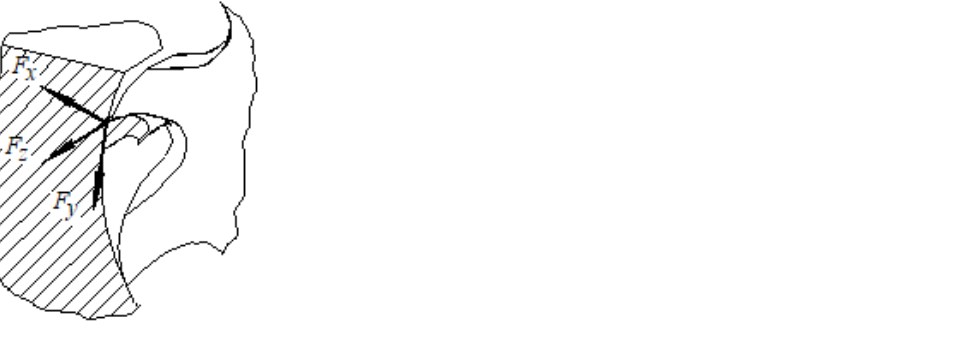
Figure 3. Decomposition of the cutting force with which the peak of a cutting tooth of a disk cutter acts on the stock material.